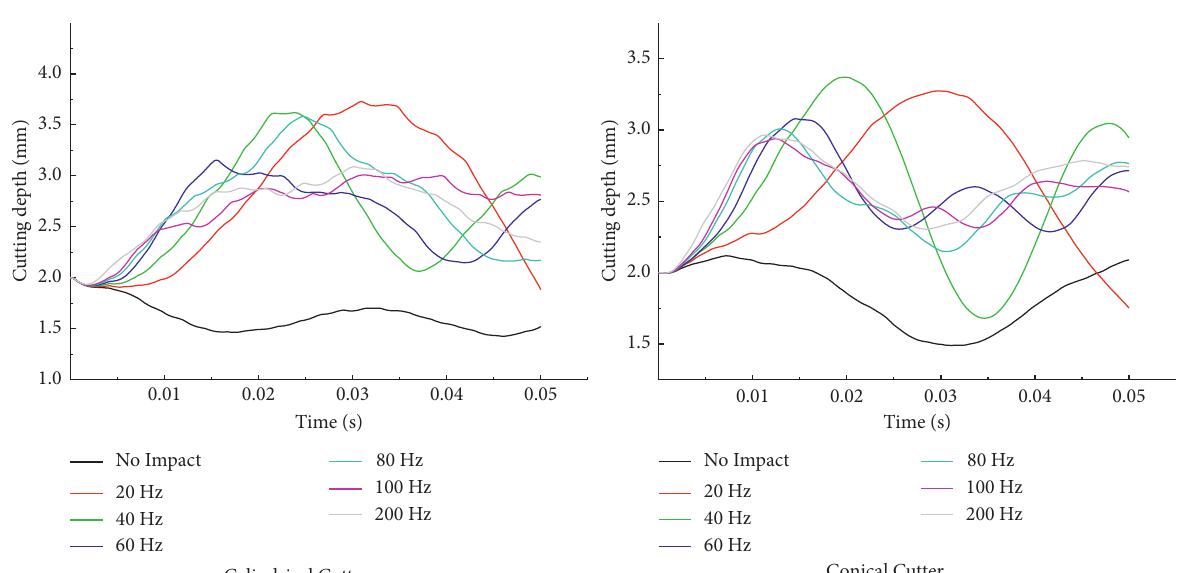
Figure 6: Cutting depth-time